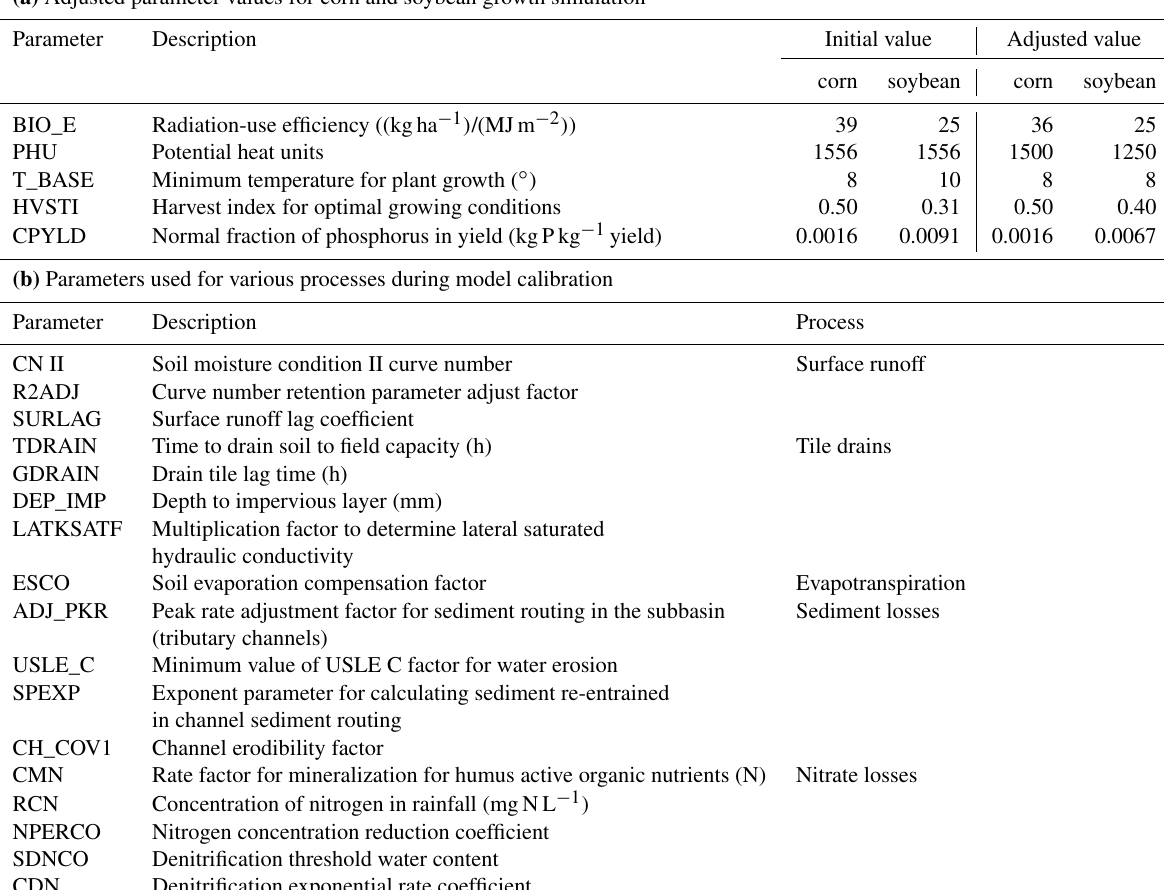
Table 2. Adjusted parameter values for plant growth simulation (a) , and parameters used for model calibration (b) . (a) Adjusted parameter values for corn and soybean growth